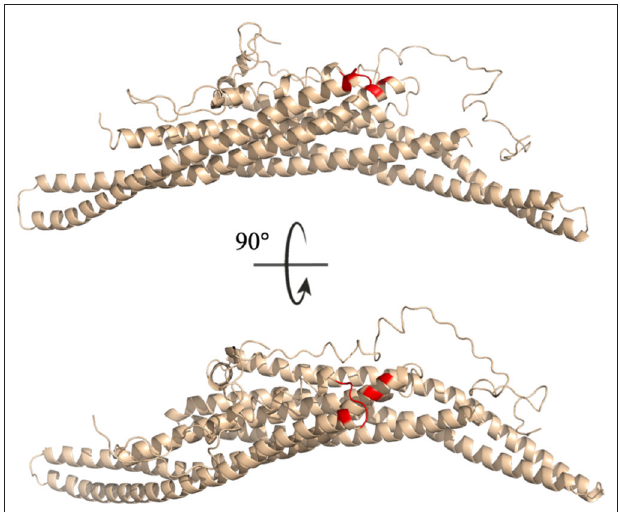
FIGURE 10 | Key interaction pairs between the C-terminal and the BAR domain. All key residues listed in Table 3 have been colored red.